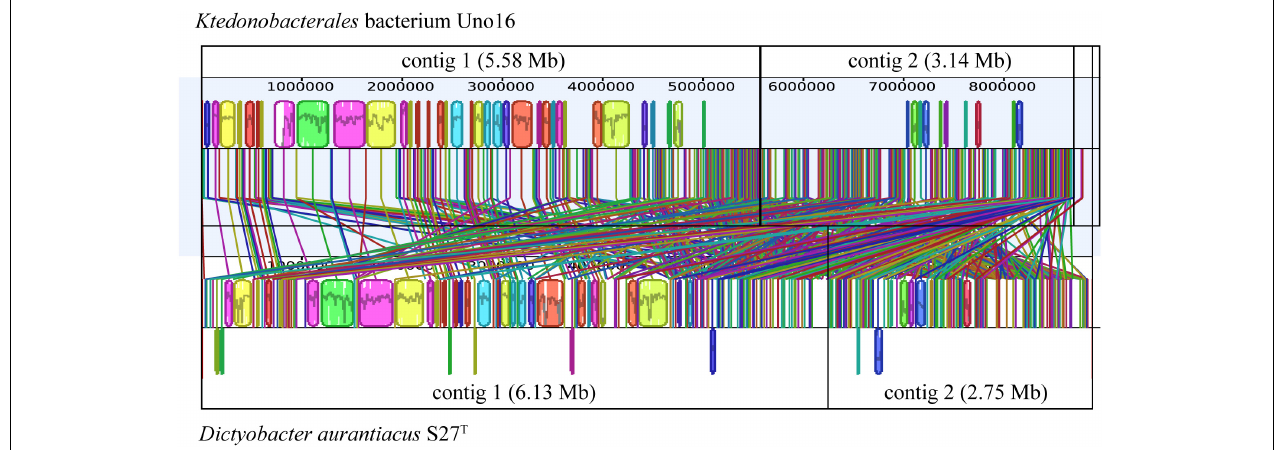
FIGURE 4 | Comparative analyses of strains D. aurantiacus S27 T and Ktedonobacterales bacterium Uno16. The colored boxes represent homologous regions with another genome. Lines between two genomes trace each homologous region between